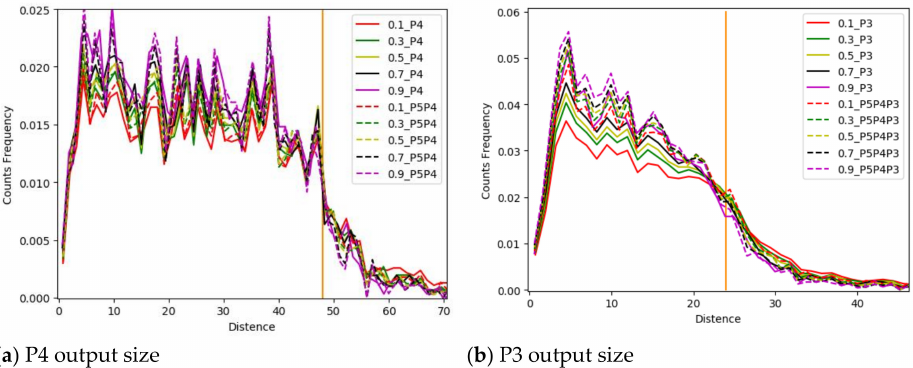
Figure 12. Frequency histogram of distance between single output layer and filtration layer anchor point.